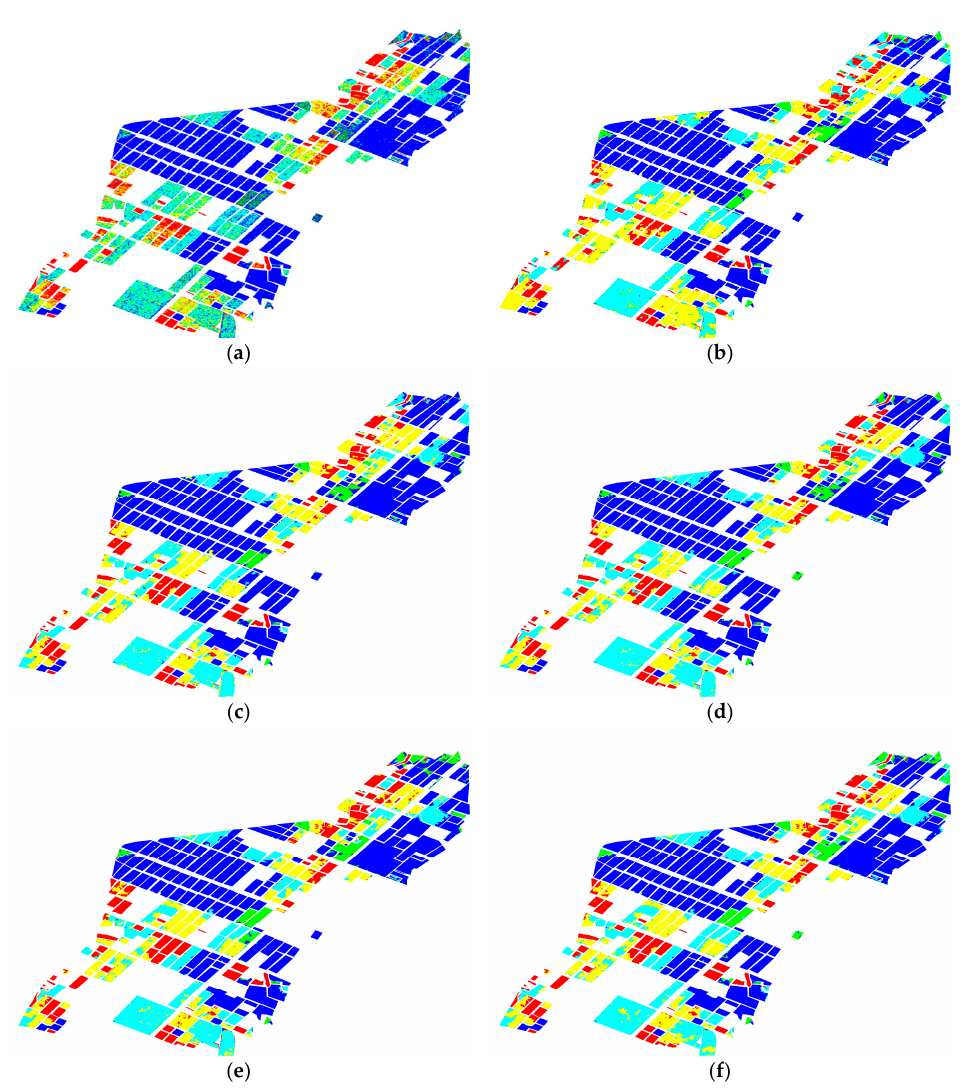
Figure 10. Classification results for the UAVSAR imagery with different sample selection strategies: ( a ) MBT_pixel; ( b ) MBT_T3; ( c ) RS; ( d ) MI; ( e ) BT; ( f ) MBT.